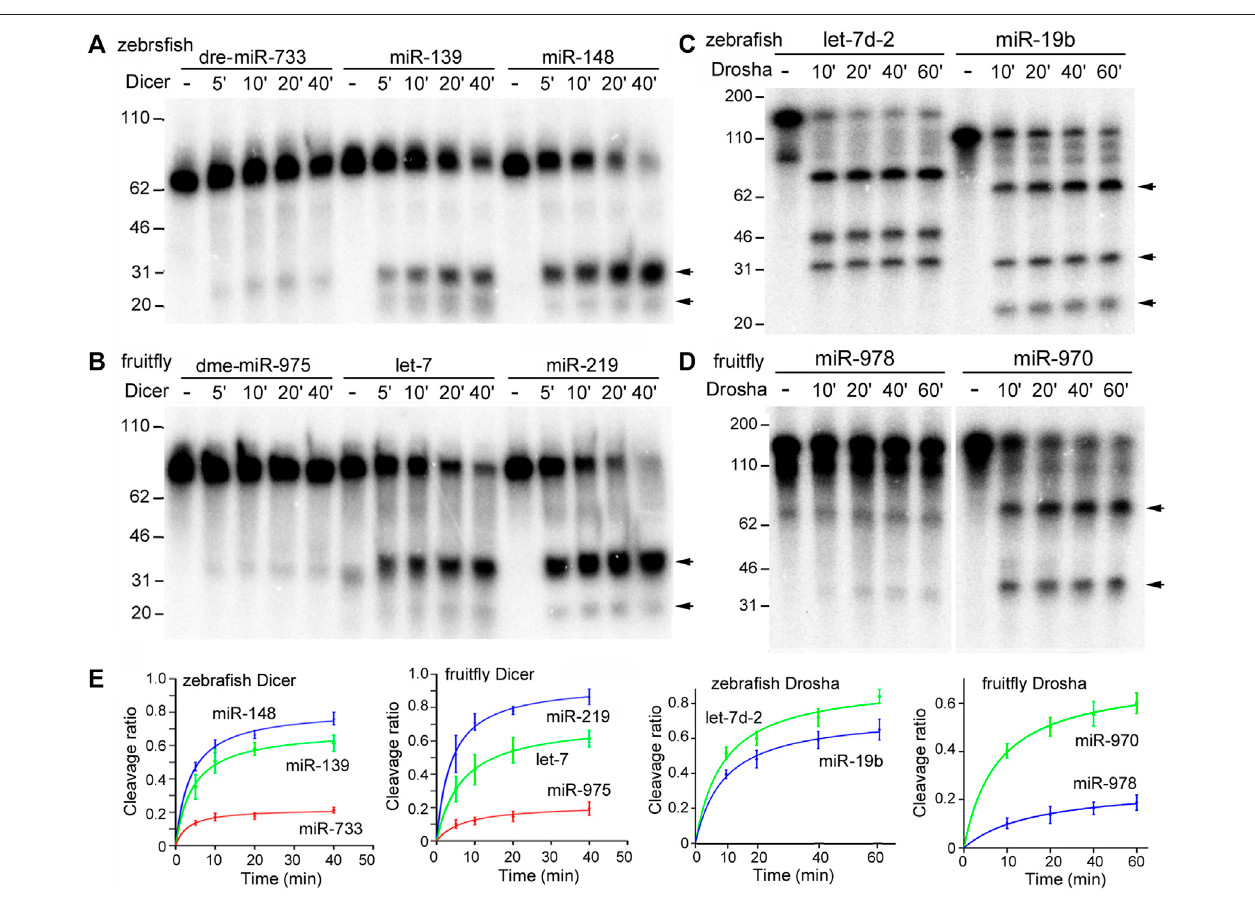
FIGURE 2 | Time-course processing reactions by zebra fi sh and fruit fl y Dicer and Drosha. (A) Cleavage of dre-pre-miRNAs by zebra fi sh Dicer. Arrows point to cleavage products. Timepoints are indicated on top of the gel image, DNA markers (in nt) shown on the left. (B) Cleavage of dme-pre-miRNAs by fruit fl y Dicer. (C) Cleavage of dre-pri-miRNAs by zebra fi sh Drosha. (D) Cleavage of dme-pri-miRNAs by fruit fl y Drosha. (E) Quanti fi cation of the data in (A – D) . The y-axes are the raw substrate cleavage ratios, with averages and standard deviations, plotted against the different time points in the x-axes.